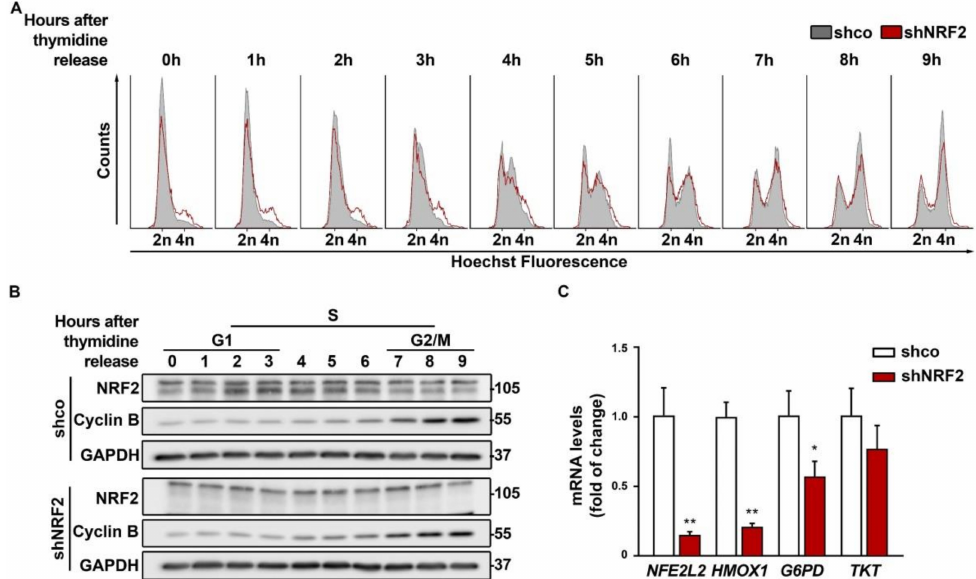
Figure 4. Double thymidine pulse for cell cycle synchronization indicates oscillation of NRF2 levels along the G1/S transition. U–373 MG cells were transduced with lentiviral vectors